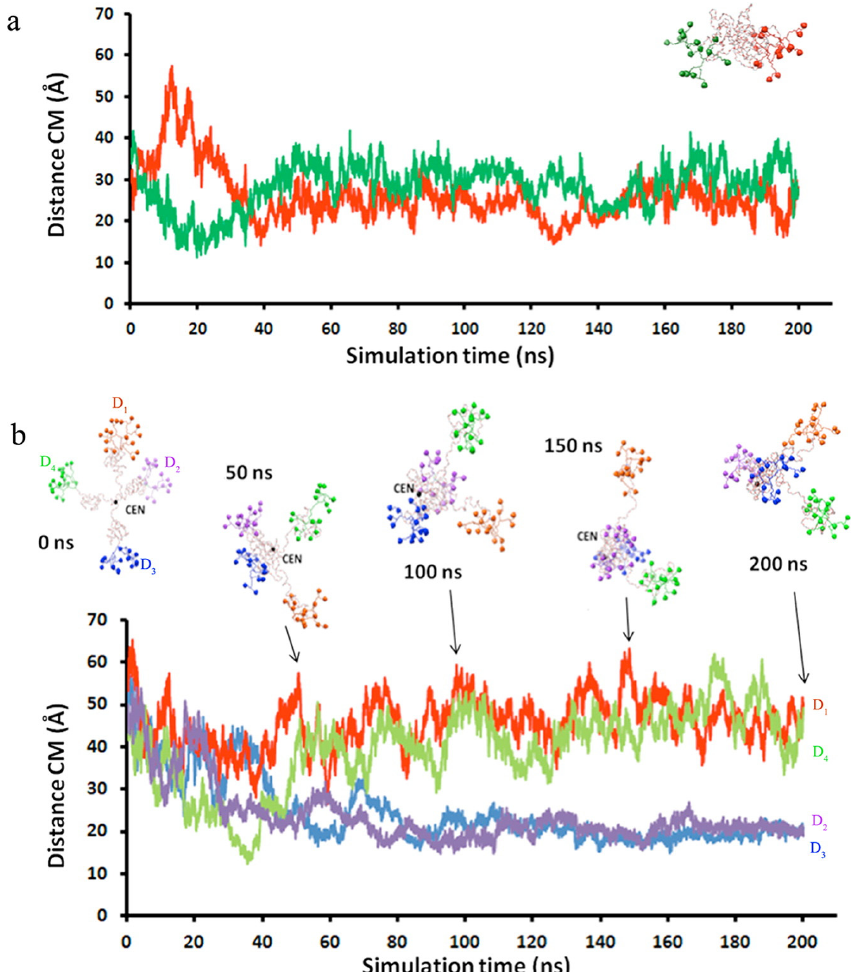
Figure 6. Snapshots of molecular dynamics (MD) simulations of dendrimers grafted with ( a ) 2-arm PEG cores and ( b ) 4-arm PEG cores. (Reprinted with permission from [134]. Copyright 2013 American Chemical